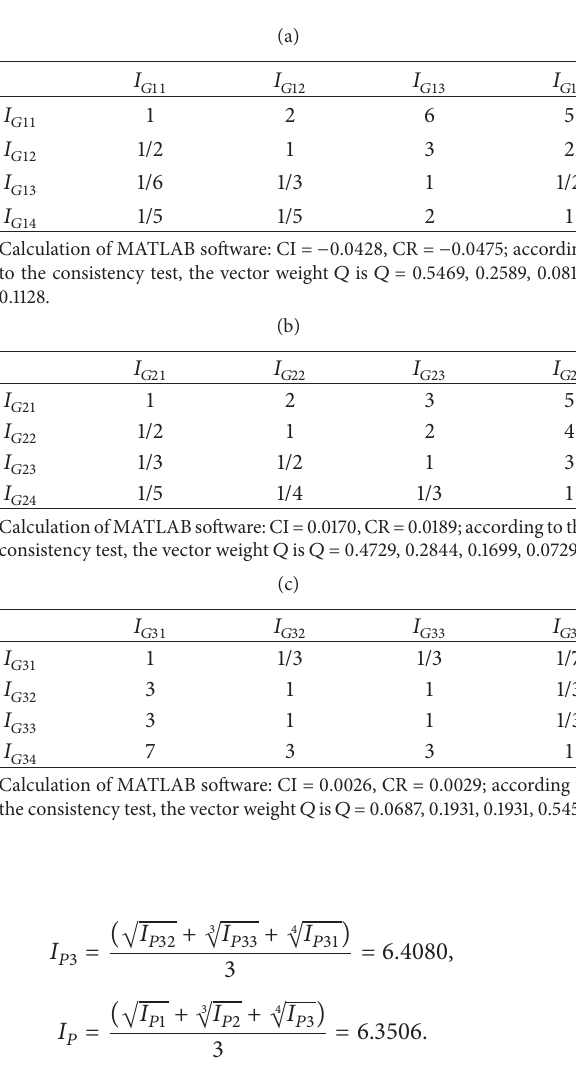
Table 10: Green development index judgment matrix of tertiary indicators relative to secondary